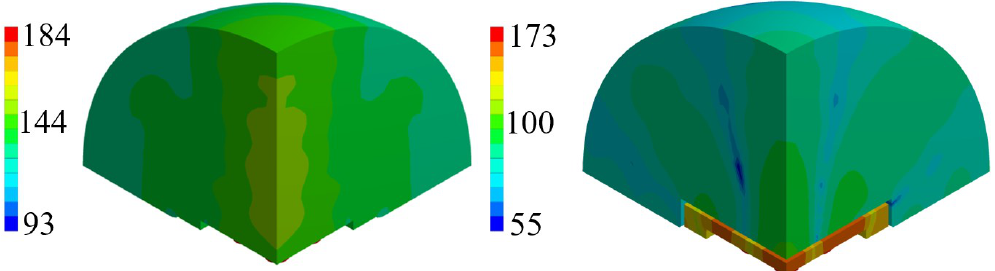
Figure 14. SPL contour plot (dB) at the performing fundamental frequency of 93.0 kHz (3 V bias): unpackaged device ( left ), packaged device ( right